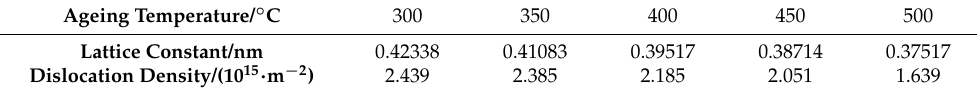
Figure 2. TEM image after 30 min ageing at different temperatures: ( a ) 300 °C ; ( b ) SAED of the square area in ( a ); ( c ) 350 °C ; ( d ) 400 °C ; ( e ) 450 °C ; ( f ) SAED of the square area in ( e ); ( g ) IFFT image of the square area in ( e ); ( h ) 500 °C . Table 1. Lattice distortion and dislocation density after 30 min ageing at different temperatures. Ageing Temperature/ °C